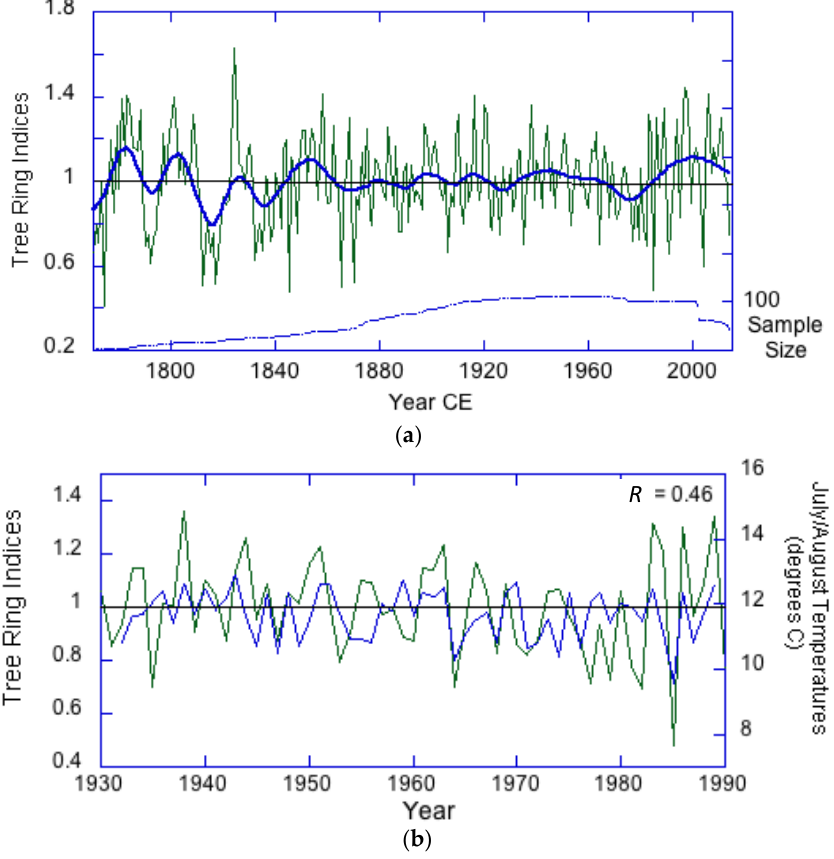
Figure 6. ( a ) Composite Kamchatka birch ring ‐ width chronology. Blue line shows changing sample size; ( b ) Kamchatka birch chronology (green) plotted with July/August average temperatures from Ust ‐ Kamchatsky ( R = 0.46; p > 0.001).